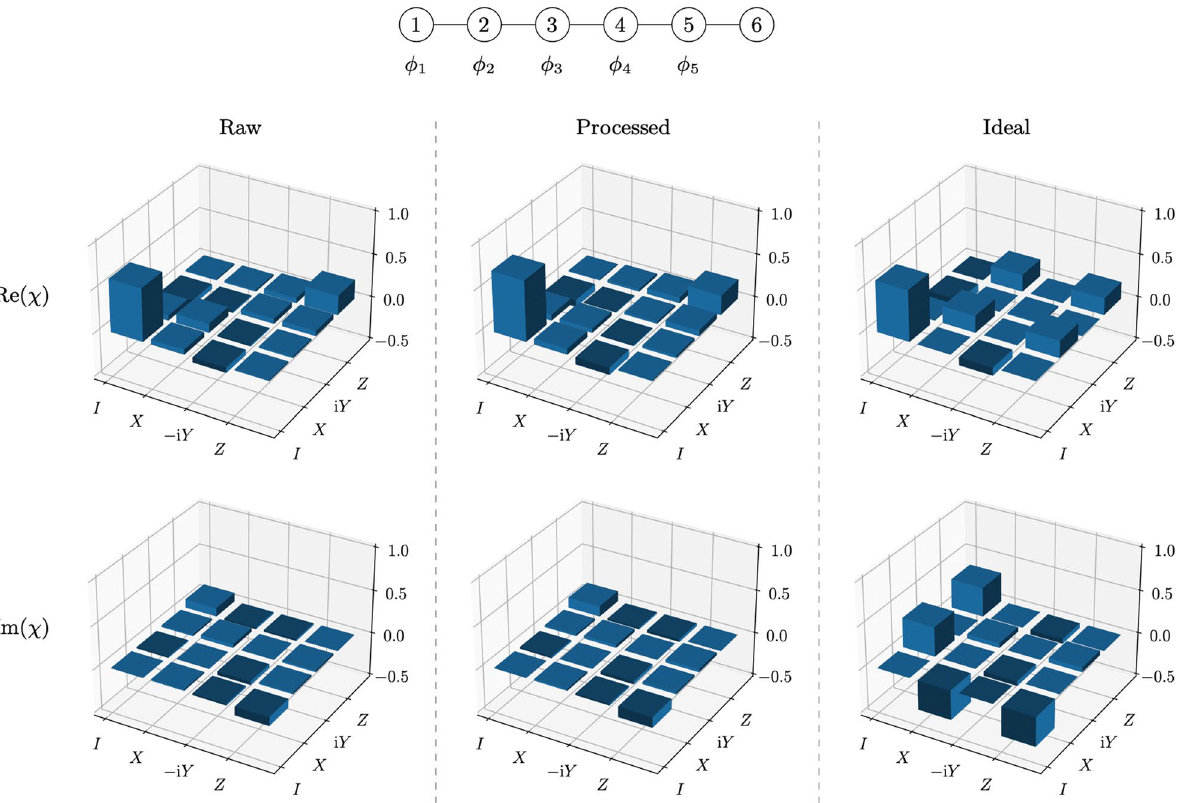
Figure 3. Example of channel tomography results for the random unitary that agreed least with the ideal 00000 with the exact 3-design on the ibmq_toronto quantum case generated for measurement outcome m = processor. The diagram at the top shows the entangled 6-qubit cluster state with the measurements